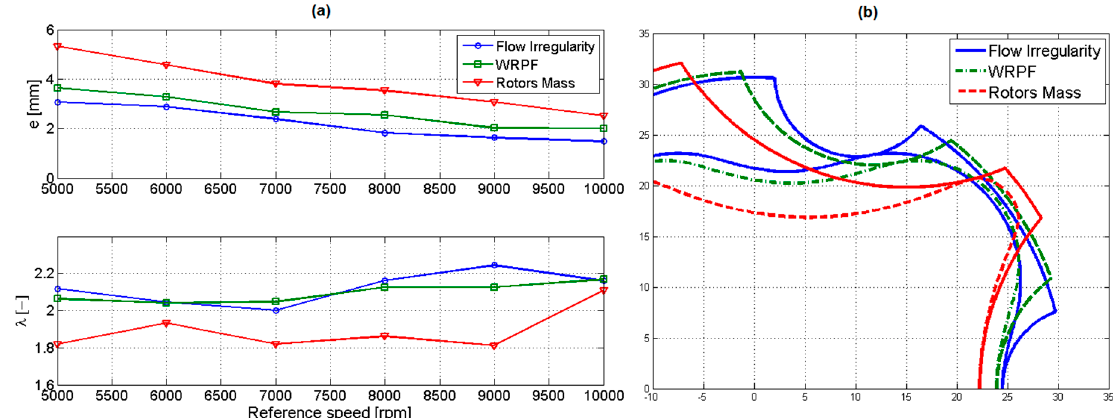
Figure 14. Optimized cycloidal profiles. ( a ) Geometrical parameters ( b ) comparison for 5000 rpm .